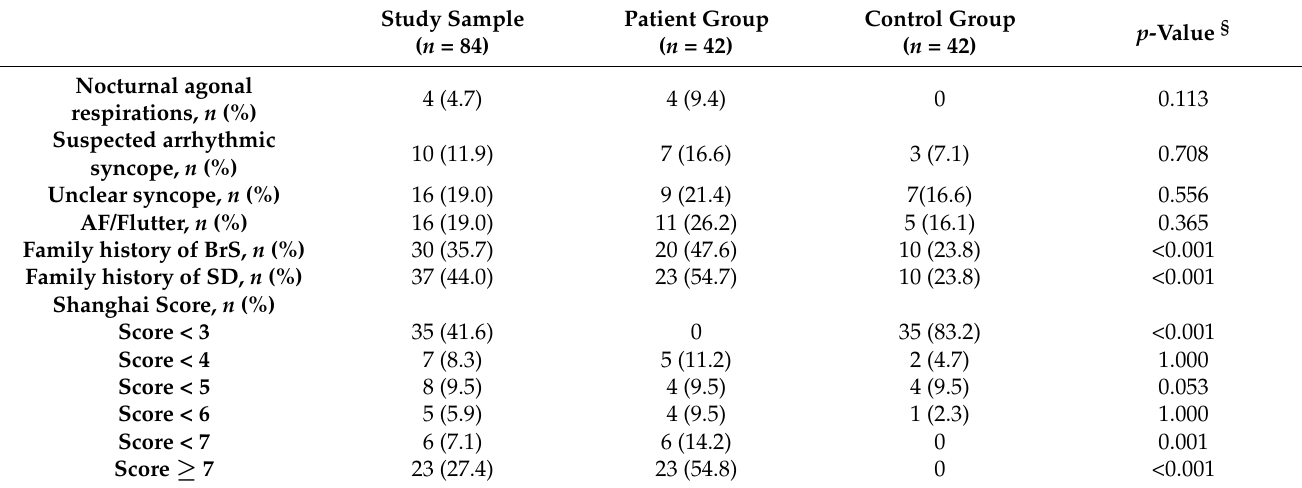
2.3. Flow Cytometric Analysis of PBMCs Reveals a Reduction in Membrane Protein Sialylation Levels